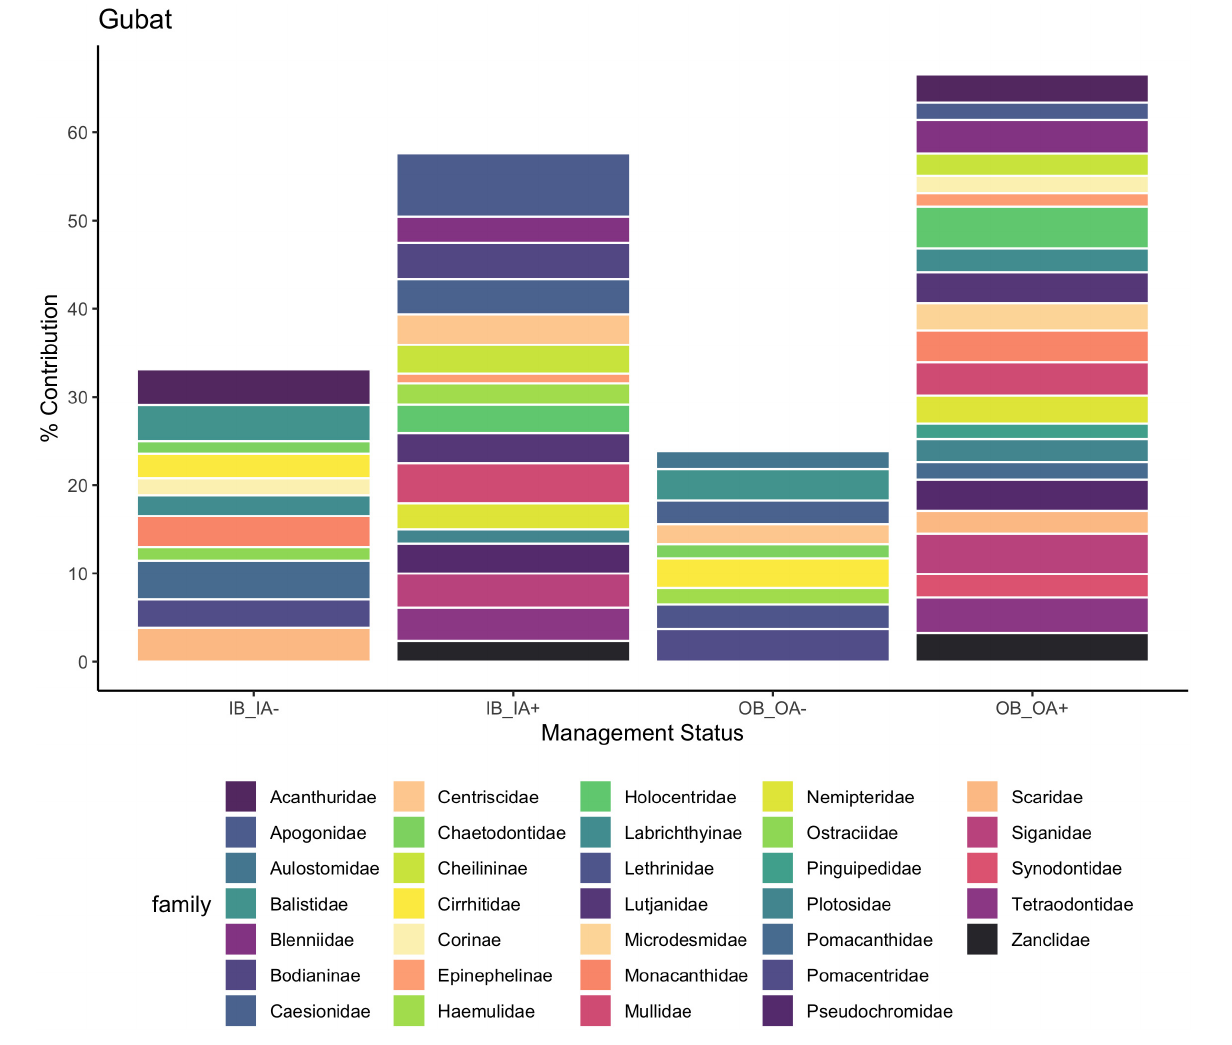
FIGURE 8 | Percent contribution to the dissimilarity between inside the marine reserves before and after CBM, inside and outside marine reserves before CBM, and inside and outside after CBM. OA, outside marine reserve; after CBM implementation; OB, outside marine reserve; before CBM implementation; IA, inside marine reserve; after CBM implementation; IB, inside marine reserve; before CBM implementation. + means that there was higher abundance inside the reserve or after CBM, – means there was lower abundance inside the reserve or after